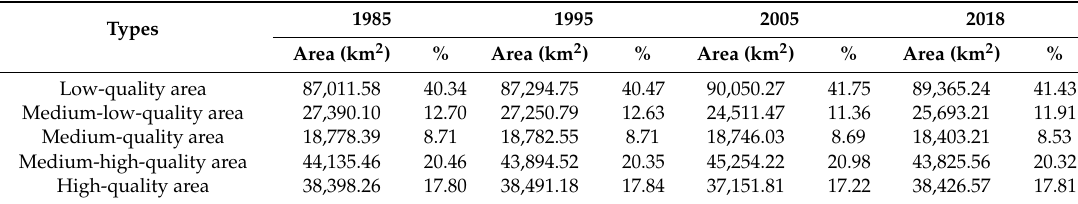
Table 4. Changes in the area of ecological environment quality in the Beijing–Tianjin–Hebei (BTH) region from 1985 to